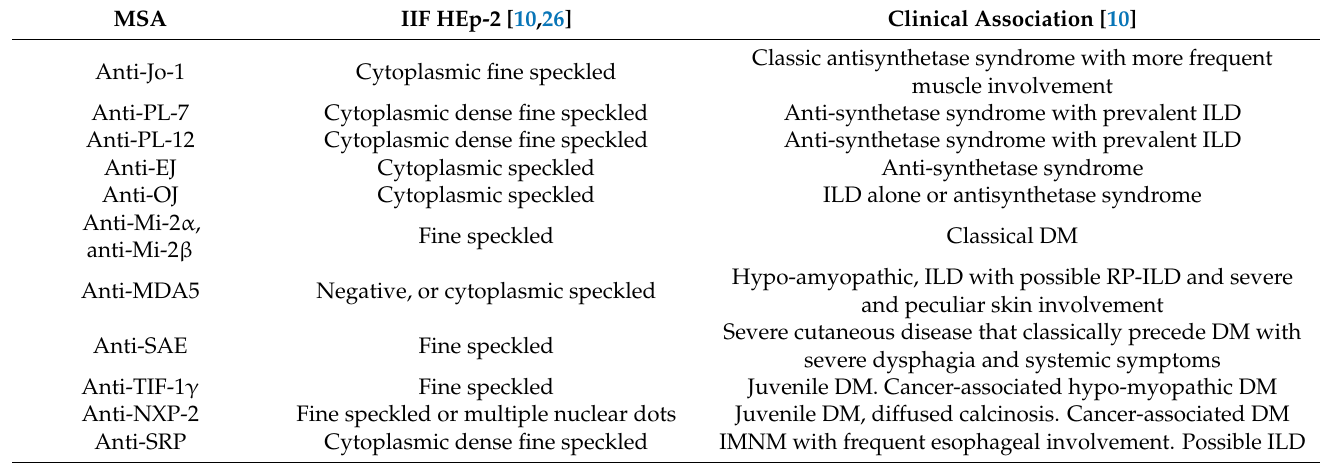
Table 1. Summary of IIF pattern and main features of